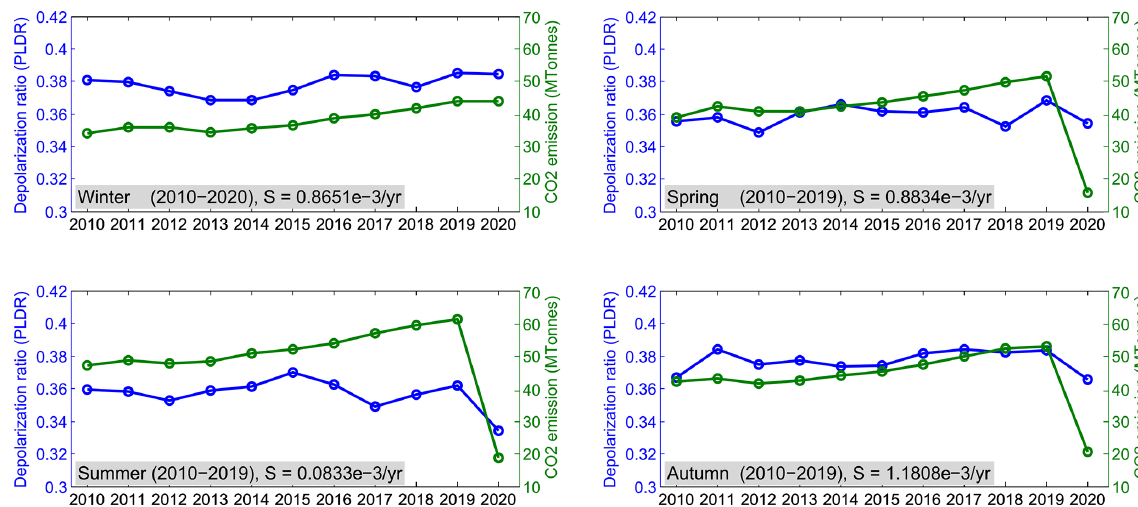
Figure 10. Long-term trends in cirrus PLDR in different seasons and their correlations with the corresponding CO 2 emissions from aviation in Europe. There are increasing trends in PLDR as well as CO 2 emissions from aviation in all seasons in the 10 years before COVID-19. The correlation analysis between both parameters shows a strong correlation in winter, spring, and autumn, but a weak correlation in summer. Table 5. Correlation coefficients between the monthly PLDR values of cirrus clouds within the altitude from 6 to 13km and corresponding CO 2 emissions from aviation as well as number of flights in Europe in different